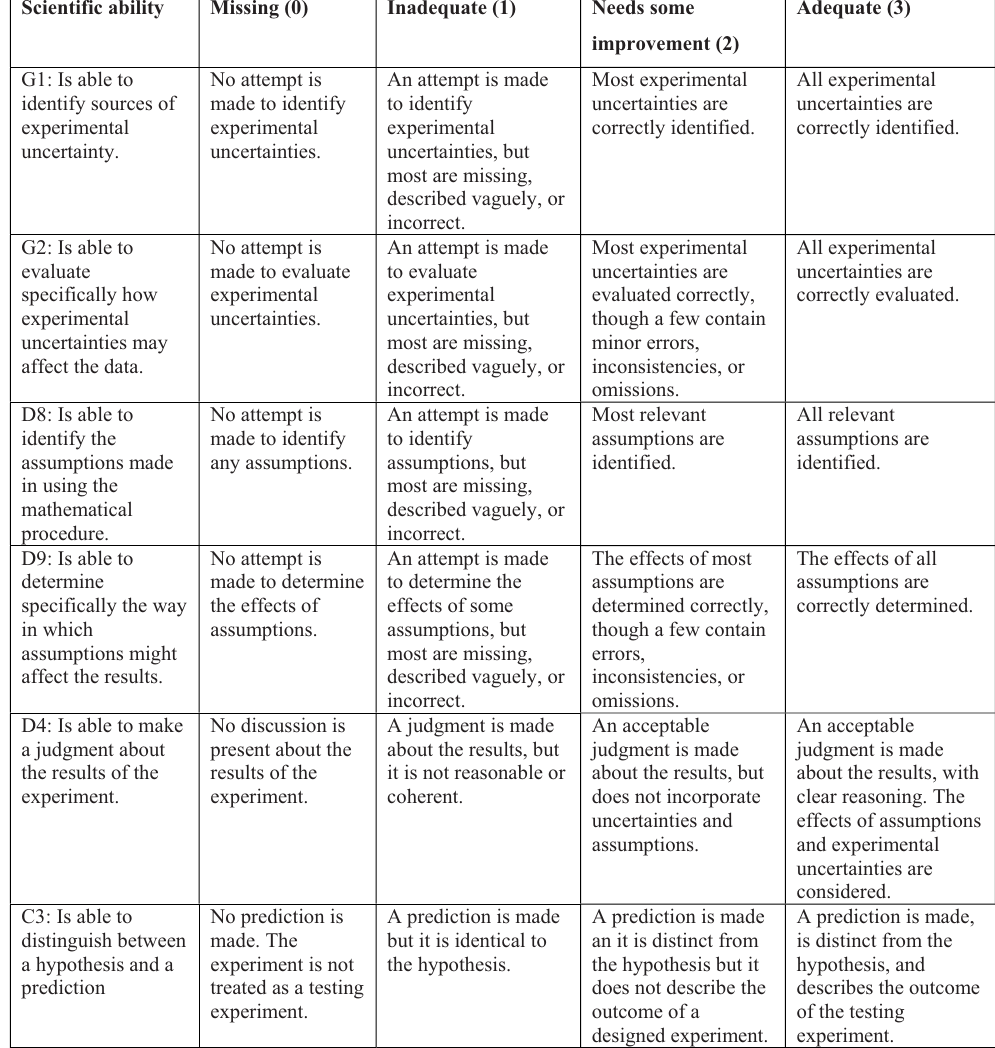
TABLE III. Some of the scientific abilities rubrics used in the